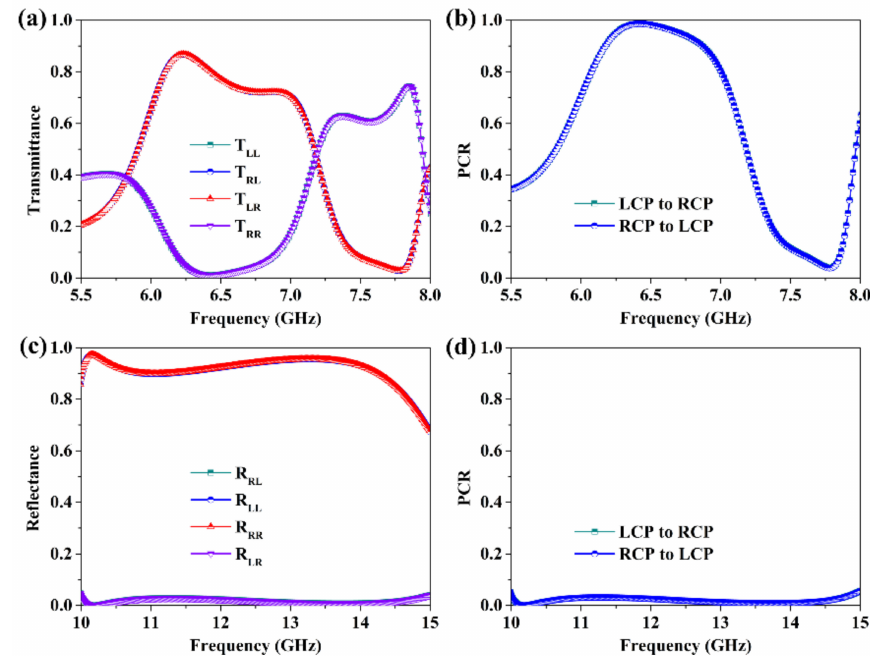
Figure 7. Simulation results of the designed metagrating for the circularly polarized waves at normal incidence. ( a ) Transmittance and ( b ) PCR spectra in transmission mode, ( c ) reflectance and ( d ) PCR spectra in reflection